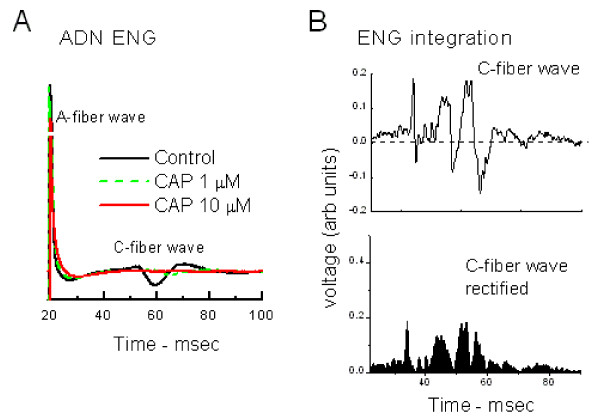
Capsaicin depressed the C-wave recorded from the whole nerve trunk of the aortic depressor nerve (ADN). The ADN electroneurogram (ENG) had an early arriving A-wave and a late broad, C-wave (panel A). This representative ADN was estimated to be 21 mm in length. Application of a pledget soaked in saline (Control), 1 μM CAP (green, broken) and then 10 μM CAP (red) for ten min at each condition resulted in progressive depression and then elimination of the slow conducting (0.5 m/sec) C-wave while the fast conducting, A-wave was preserved. Note that the y-axis is broken to better display the C-wave. Amplitude units are arbitrary since the degree of electrical isolation varied from nerve to nerve and was affected by saline shunting and the length of free nerve ending. For semi-quantitative comparisons across nerves, segments of the ENG were full wave rectified and digitally integrated to represent the amplitude of the entire wave (panel B, lower).